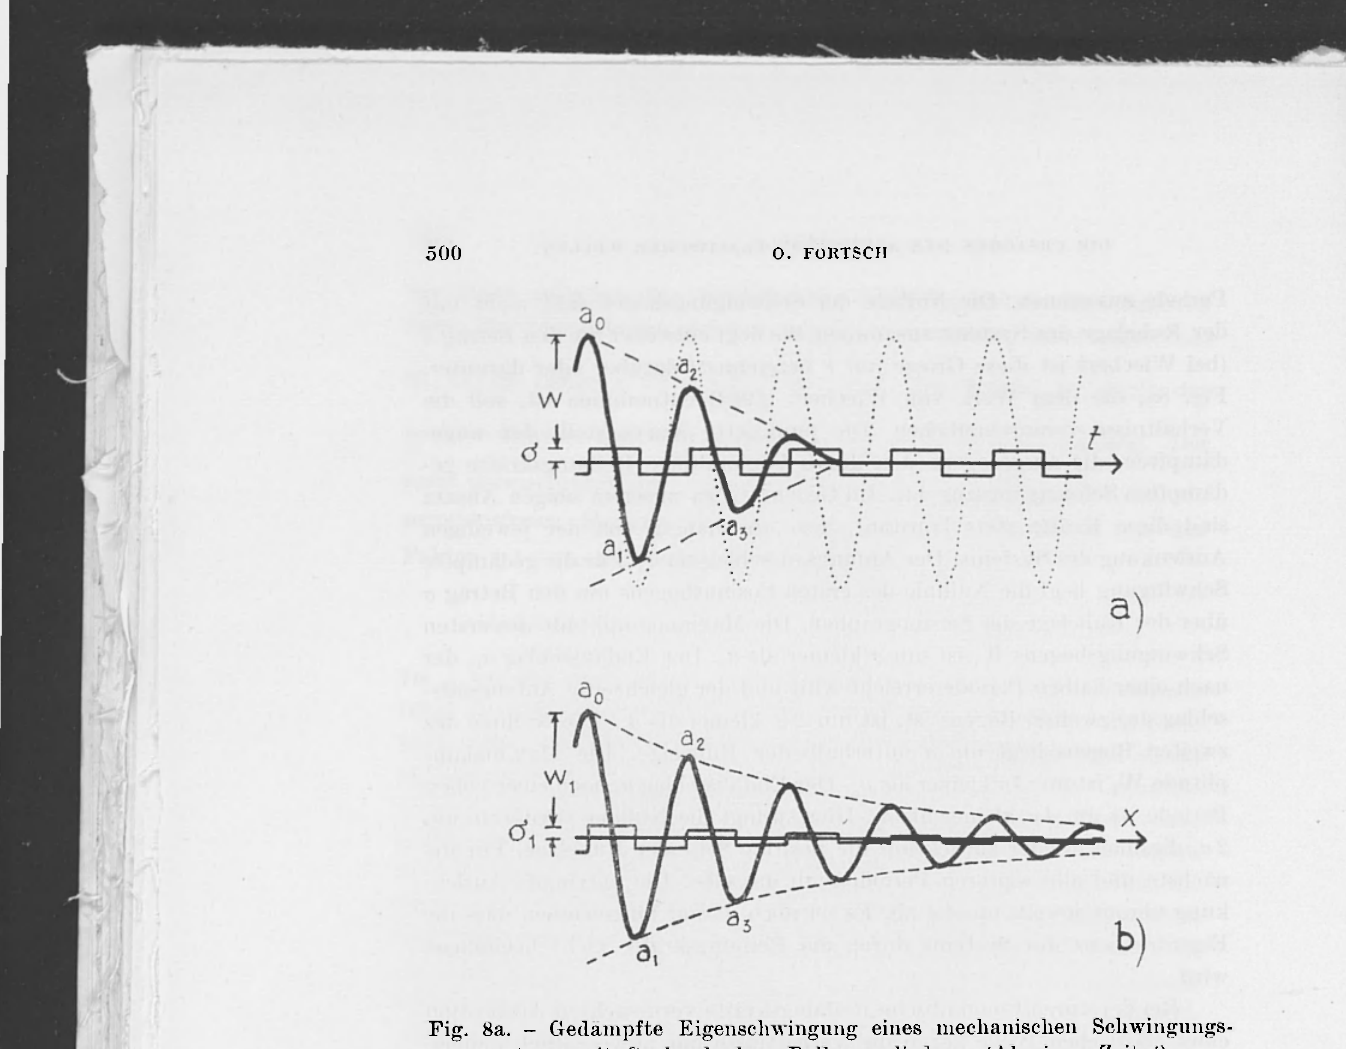
Fig. 8a. - Gedampfte Eigenschwingung eines mechanischen Scliwingungs- systems mit Coulombschen Reibungsgliedern. (Àbszisse: Zeit t). Punktiert: Ungediimpfte Schwingung. Ausgezogen: Gedampfte Schwingung des Systems.